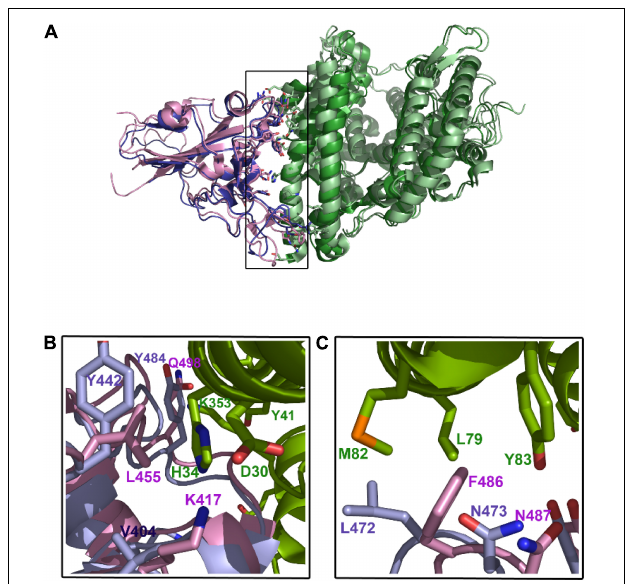
FIGURE 3 | Interacting region between SARS-CoV-2 and ACE2. (A) Structures of the RBDs of both SARS-CoV ( slate blue ) and SARS-CoV-2 ( pink ) in complex with ACE-2 receptor ( green ). (B) amino-acid residues of SARS-CoV-2 RBD domain ( pink ) interacting with the N-terminus and C-end of the α 1-helix of ACE-2 receptor ( green ). Equivalent positions in SARS-CoV (2002/3) are shown ( light blue ). (C) , the main differences between both spike viral proteins are the substitution of Val404 for Lys417, which favors the polar interaction with Asp30 of ACE-2, and the substitution of Leu472 for Phe486, which enables the formation of Van der Waals bonds with Met82 and hydrophobic interactions with Tyr83.